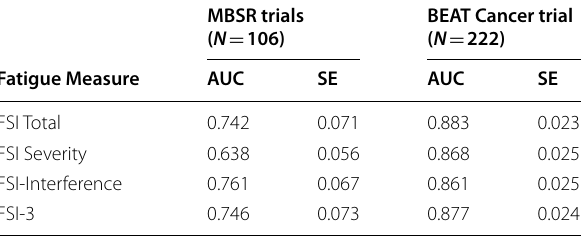
Table 5 Area under the ROC Curve (AUC) for fatigue measures